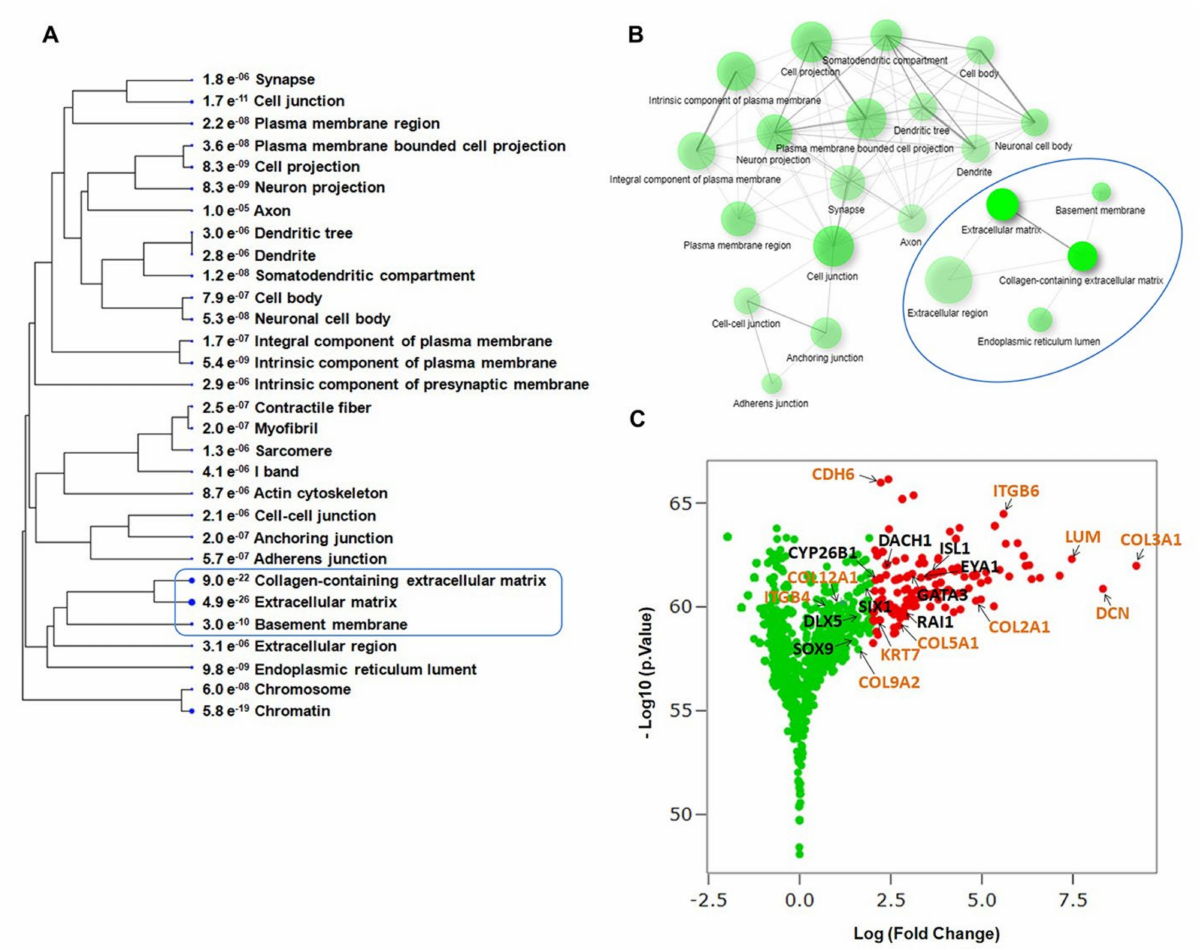
Figure 4. Biological characteristic analysis of top cellular component during hiPSC differentiation into otic sensory cells. ( A ) Cellular component categories of upregulated genes that were significantly enriched in differentiated hiPSCs at day 13 in vitro relative to undifferentiated hiPSCs ( p -values for the lack of enrichment are shown). The ECM and Collagen-containing ECM are among the top-clustered cellular components. ( B ) Network visualization of enriched cellular components performed by GO analysis revealed the ECM and Collagen-containing ECM are the highly enriched cellular components in the gene signature of otic sensory cells at day 13 in vitro. ( C ) Volcano plots representing the up-regulated genes in differentiated hiPSCs at day 13 in vitro compared to undifferentiated hiPSCs at day 0 in vitro. Adjusted p -value (or FDR) Threshold < 0.05 and log2 (Fold Change) >2. Labeled are differentially upregulated genes with log2 (FC)>2 (red dots) that includes ECM and ITG gene